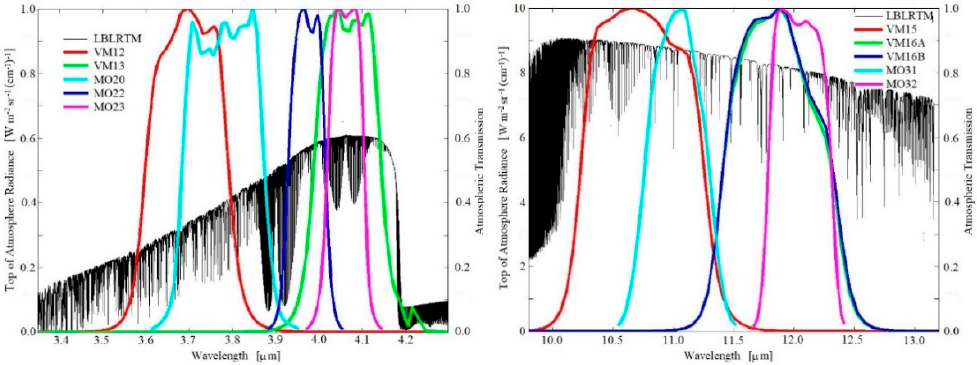
Figure 1. Relative Spectral Response (RSR) functions for the Infrared (IR) bands used for Sea-Surface Temperature (SST skin ) retrieval for Moderate-resolution Imaging Spectroradiometer (MODIS) and Visible Infrared Imaging Radiometer Suite (VIIRS). The colored lines are the broadband RSR functions of the VIIRS imaging “M” bands indicated by “VMnn” and the MODIS bands indicated by “MOnn”, where nn is the band number. The RSRs are the averages over 16 detectors for VIIRS and 10 detectors for MODIS. VIIRS band 16 has two sets of detectors and the RSRs are nearly identical. The black line is the atmospheric transmission spectrum for vertical propagation through a cloud-free atmosphere. Table 1. Spectral characteristics of MODIS and VIIRS IR bands designed to be used for the retrieval of SST skin . Bandwidth is given as full width half maximum positions. The Noise Equivalent Temperature Differences (NE δ T) are specified for a typical scene temperature: 300 K for all bands except for VIIRS M13, which is 270 K. After [56] and [49].